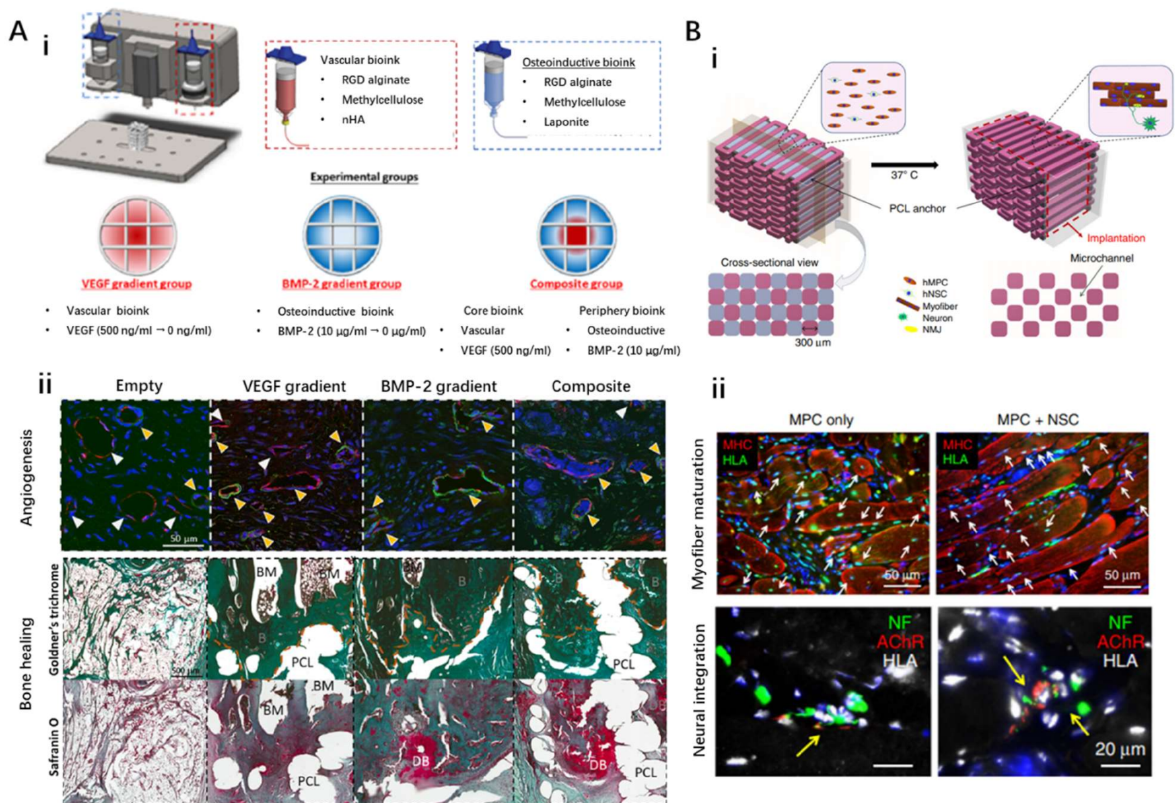
Figure 6. Three-dimensional bioprinting of vascularized and innervated musculoskeletal tissue. ( A ). ( i ) Schematic diagram of 3D bioprinting with specific bioinks and designed experimental groups; ( ii ) spatially localized VEGF and BMP-2 leads to improved angio-genesis and bone healing effects. ( B ). ( i ) Schematic diagram of the 3D bioprinted innervated skeletal muscle construct: the cell-laden bioink containing human muscle progenitor cells (hMPCs) and/or hNSCs, the acellular sacrificing bio-ink, and the supporting PCL pillar were deposited by multi-dispensing modules, and the microchannels in the con-structs were created upon the removal of the sacrificial pattern; ( ii ) comparison of myofiber maturation and neural integration performances under different experimental conditions (MPC only vs. MPC + NSC). Reproduced with permission from Refs. [140,143] with slight changes